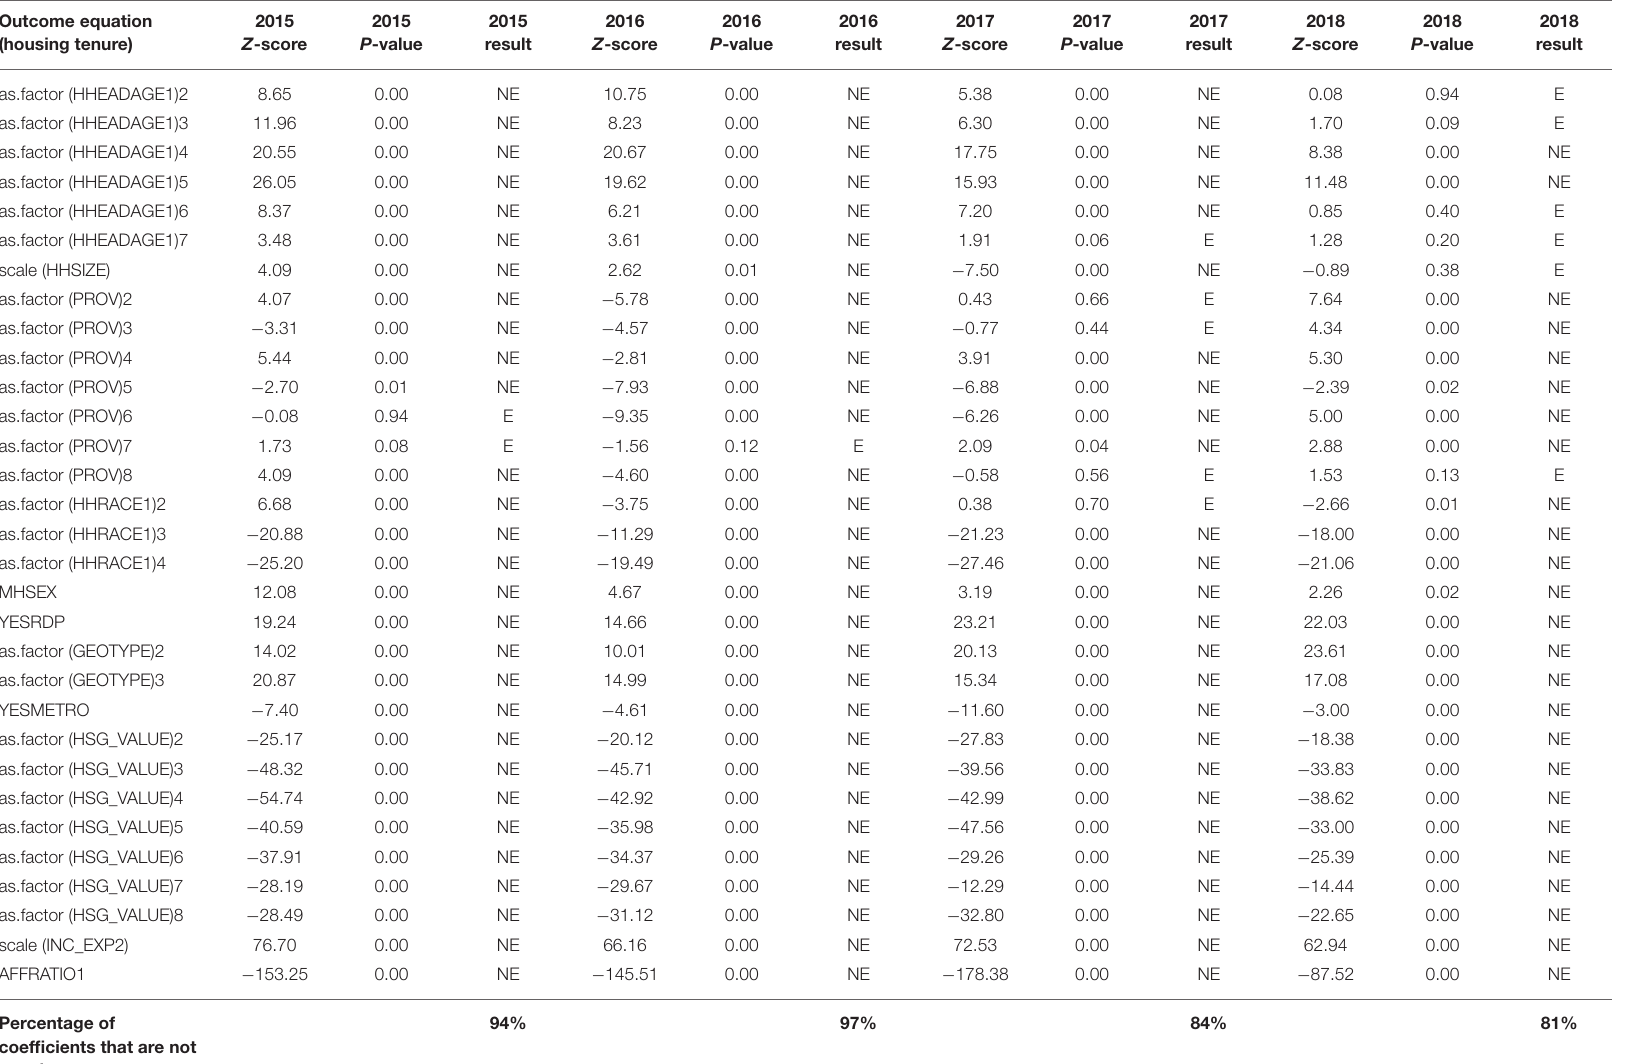
TABLE 6 | Significance of the differences between the corresponding coefficient values. Outcome equation (housing